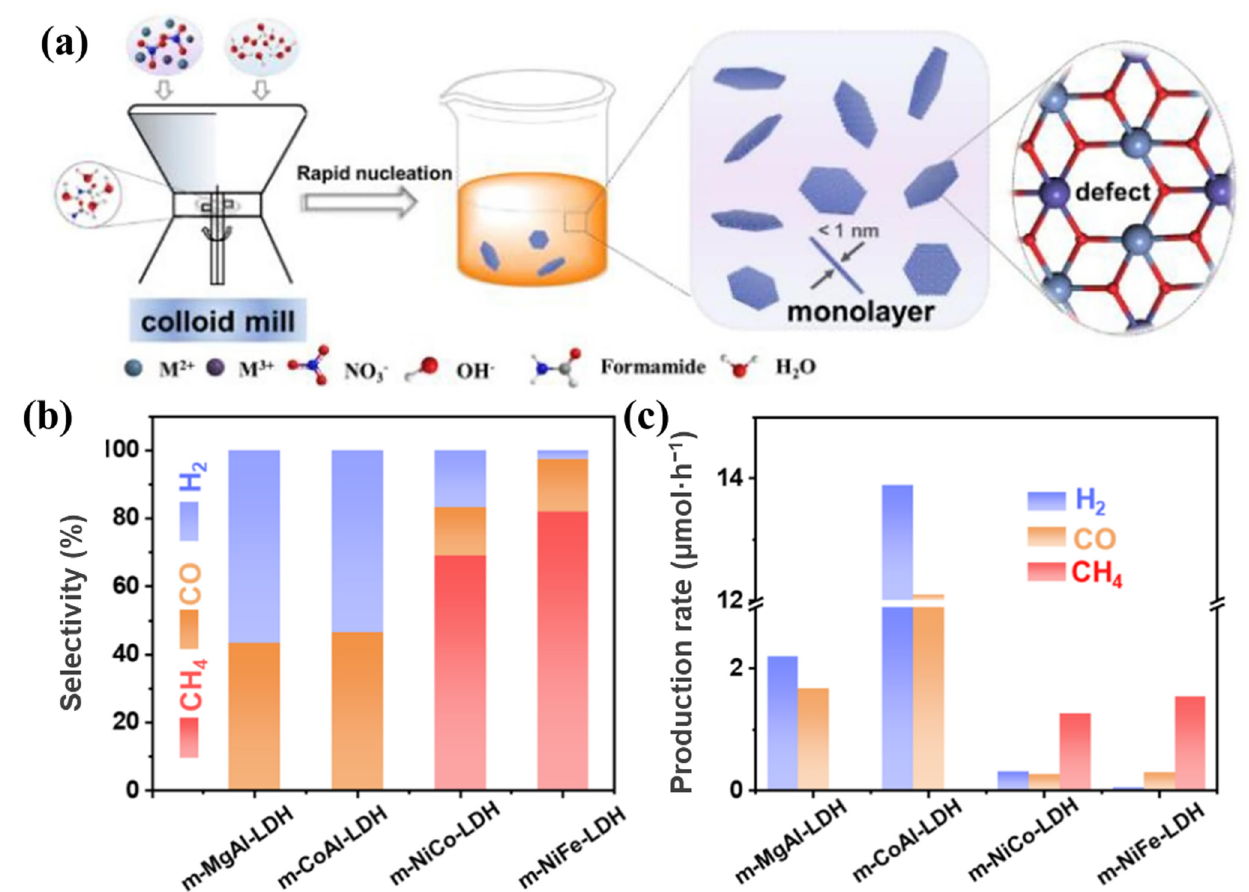
Figure 9. ( a ) Schematic illustration of synthetic process of monolayer LDHs; ( b ) selectivity and ( c ) production rate of CH 4 , CO, and H 2 in photocatalytic CO 2 reduction over different monolayer LDHs under λ ≥ 400 nm [92].